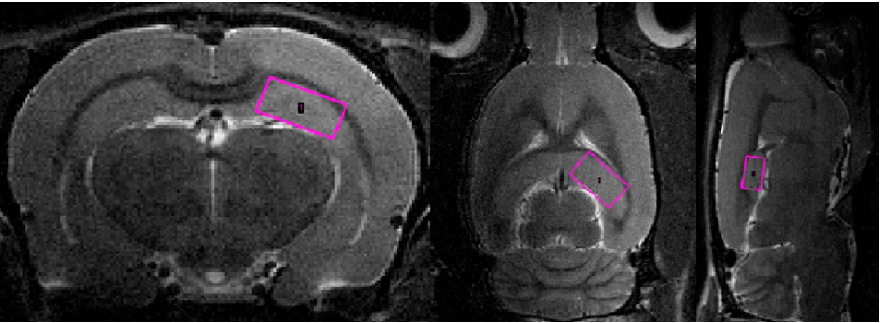
Figure 17. The regions of the MRS spectrum registration in three orthogonal planes of the brain of studied rats .